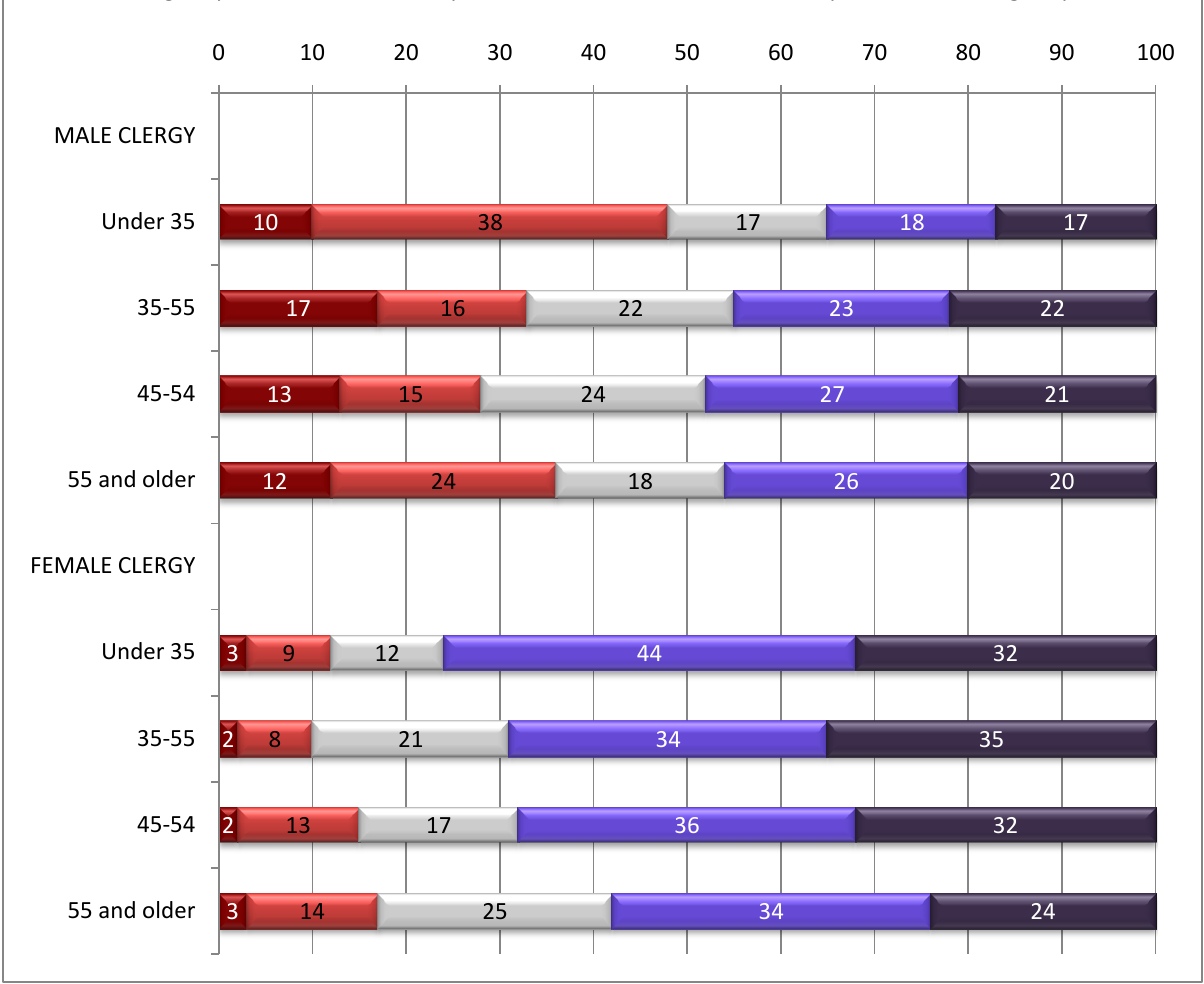
Figure 1. Theological orientation (self-report) among male and female clergy in different age-groups in Finland. Clergy Union member survey 2010, N =